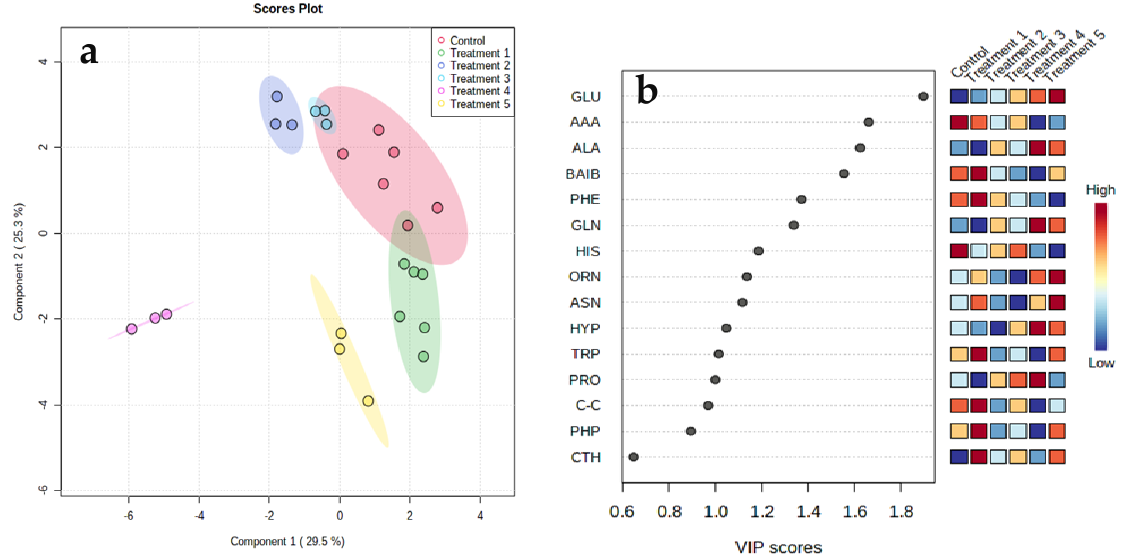
Figure 2. ( a ) Cross-validated PLS-DA score plot comparing the amino acid profiles of the clinical strain (red) and the ATCC29213 (green) strains, which shows the separation achieved during growth to the stationary phase. Colored dots represent individual replicates: 38.8% and 16.2% are the scores of Component 1 and Component 2, respectively, in the PLS-DA. ( b ) VIP plot exhibiting the 15 most important amino acids identified by PLS-DA for the cells grown to the stationary phase. Colored boxes on the right indicate the relative concentration of the corresponding amino acids in the samples. The VIP is the weighted sum of squares of the PLS-DA loading plot, taking the amount of the Y variable explained into account in each dimension.